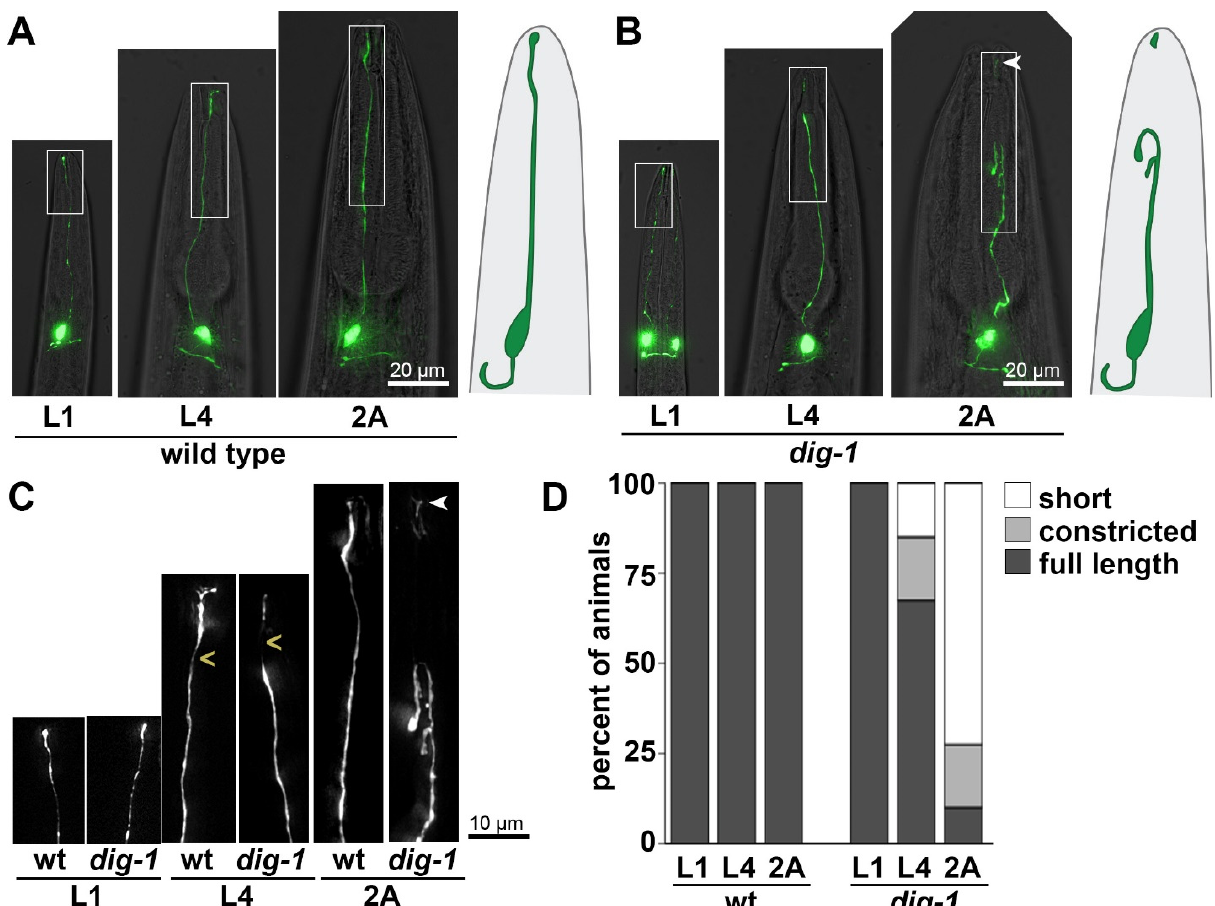
Figure 3. BAG dendrites constrict and break in dig-1 mutants. Heads of ( A ) wild-type and ( B ) dig-1 ( n1321 ) animals at the L1, L4, and 2A stages, showing apparent breakage of the BAG dendrite in L4 and 2A dig-1 animals. Animals express flp-17 pro:GFP. Schematics of BAG neurons are shown on the right. ( C ) 2 × magnification of boxed regions in ( A , B ). ( D ) Quantification of phenotype penetrance at each stage. “Constricted” refers to dendrites in which a thin, barely visible connection persists between the main dendrite and the remnant at the nose tip, as shown in the L4 dig-1 animal. This region (marked by <) appears thinner in wild-type animals as well. Arrowhead, remnant at the nose tip following dendrite breakage. n = 20 animals per genotype at each stage.